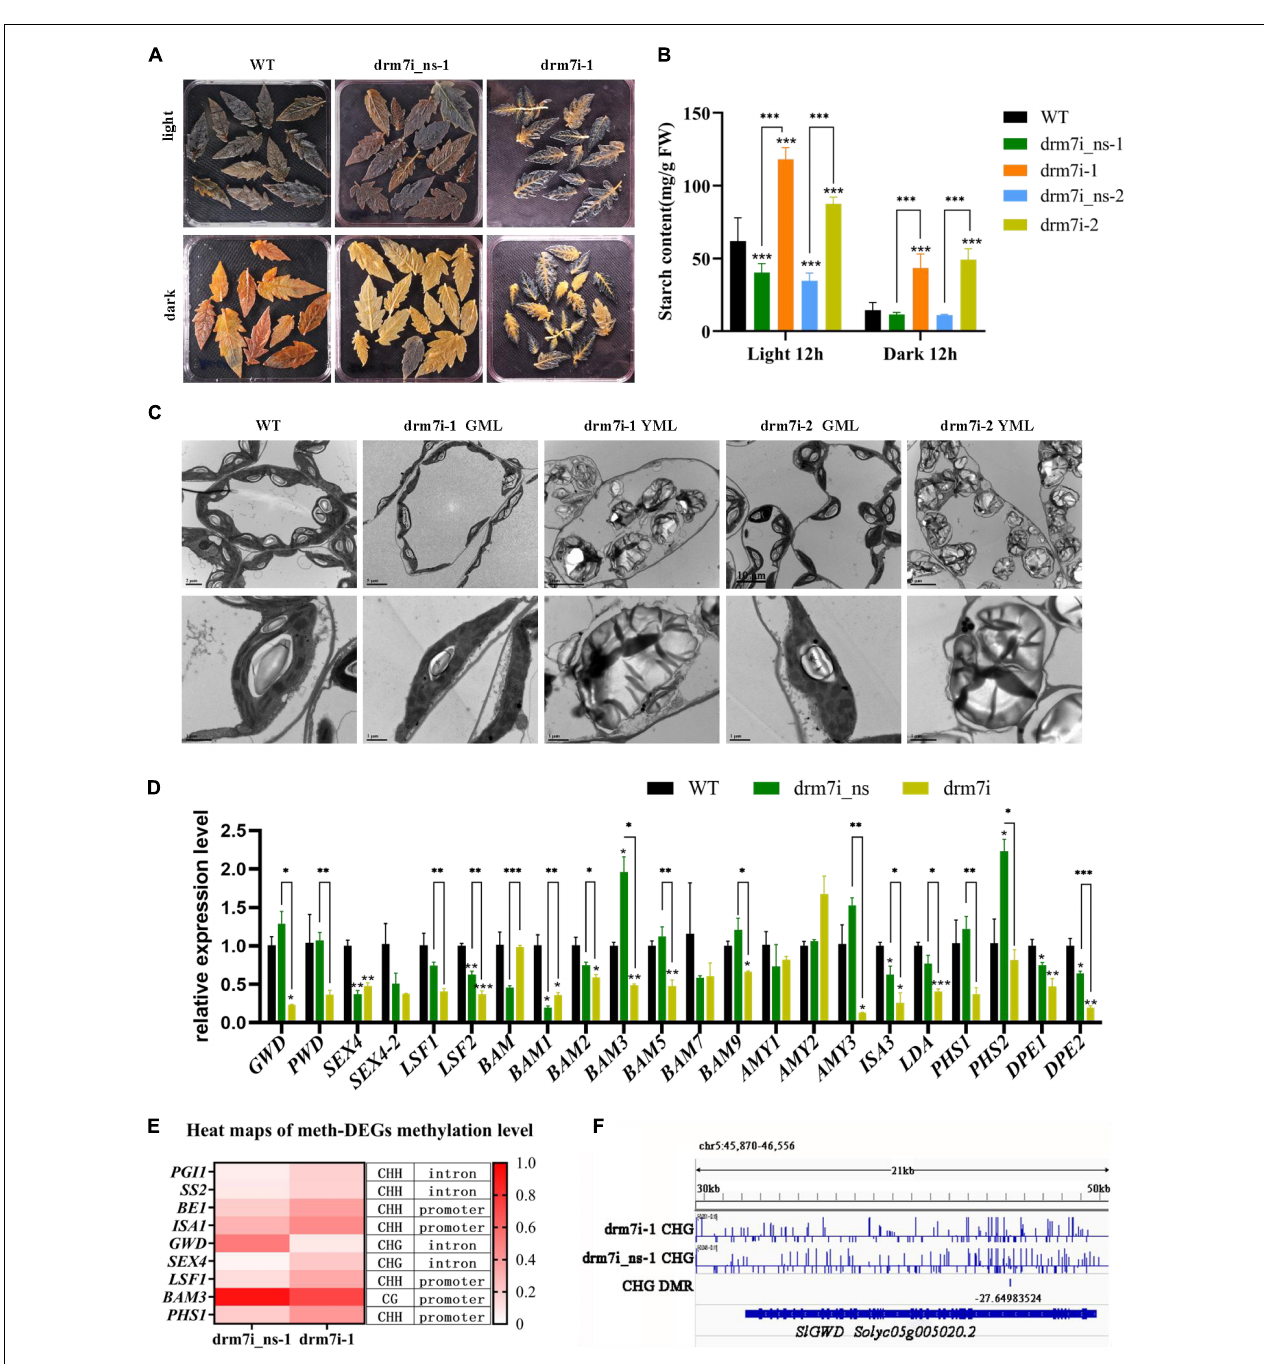
FIGURE 7 | SlDRM7 functions in starch metabolism. (A,B) Iodine-iodide kalium staining (A) and measurement (B) of starch content of the leaves in a 12-h photoperiod. By harvesting at the end of daylight (light 12 h) and the end of the night (dark 12 h), leaves at the same position of the drm7i_ns-1 and drm7i-1 lines at the six-leaf stage were stained with Lugol’s solution to visualize starch, and then the starch content was measured physiologically. (C) TEM examination of chloroplast structures. Leaf mesophyll cells were collected from the 2nd leaves of AC, two SlDRM7 -RNAi lines drm7i-1 and drm7i-2 at the six-leaf stage. The Upper and lower panels show a group of or individual chloroplasts. Bars are inserted as indicated. S, starch granule; OG, osmiophilic plastoglobuli; GL, Grana lamella; SL, stroma lamella. (D) Relative expression of genes related to starch degradation in WT, drm7i_ns-1, and drm7i-1. Data are represented as means ± SD of three biological duplicates. Asterisks (above error bar represent the difference with WT; above the short line represent the difference with drm7i_ns) indicate the significant differences ( ∗ P ≤ 0.05, ∗∗ P ≤ 0.01, ∗∗∗ P ≤ 0.001, one-way ANOVA, Tukey’s HSD). (E) Heat map of the methylation levels of meth-DEGs involved in starch metabolism. (F) Detailed DNA methylation profile at the SlGWD ( Solyc05g005020.2 ) loci. Differential DNA methylation is seen in the drm7i vs. drm7i_ns. A screenshot from the Integrative Genomics Viewer (IGV) display of whole-genome bisulfite sequencing data is shown. Vertical bars on each track indicate DNA methylation levels. Red boxes represent the